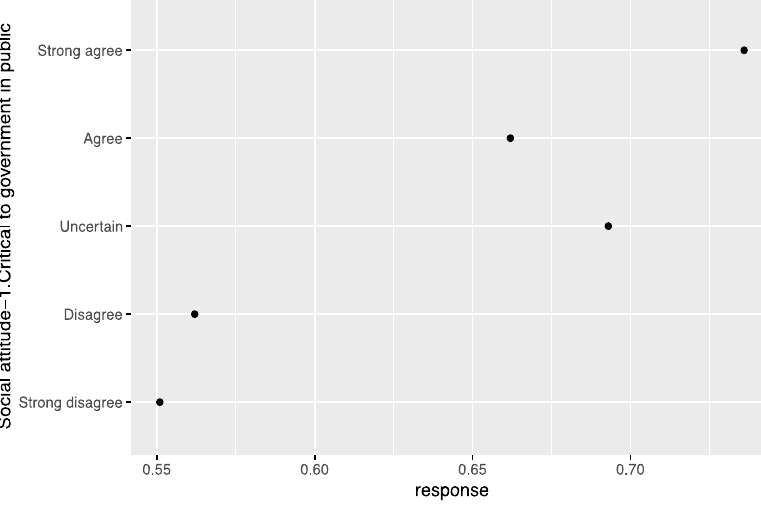
Figure 5. Zero-inflated regression coefficient of social attitude-1.